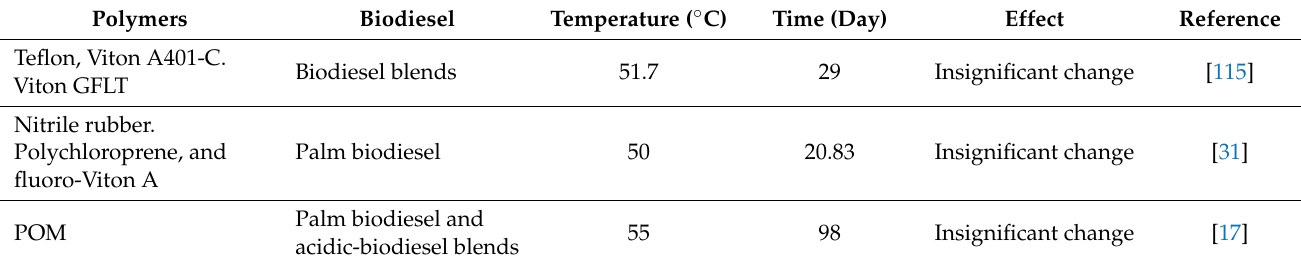
Table 10. Stable polymers toward biodiesel